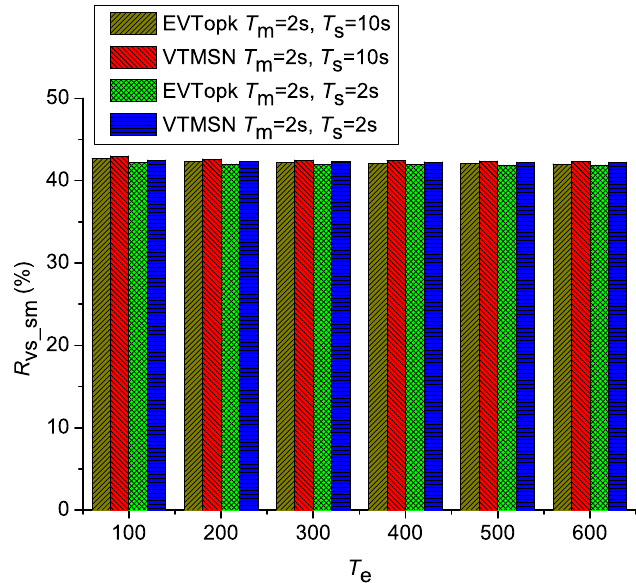
Figure 3. R vs _ sm with different settings of T m , T s , and T e .